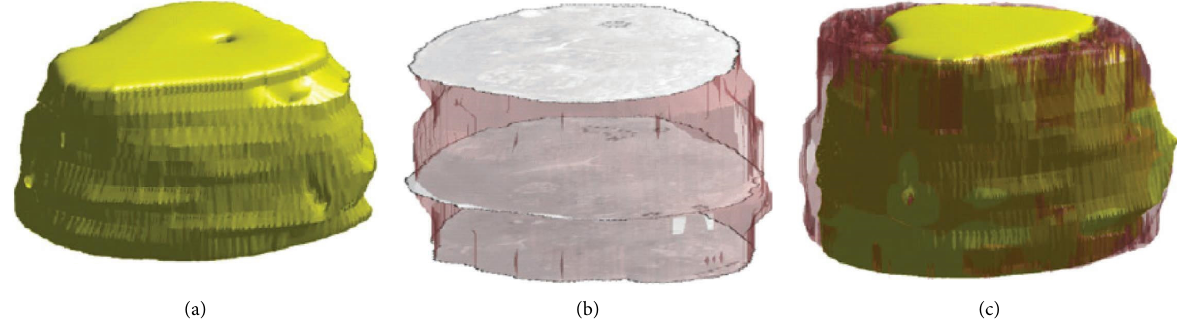
Figure 10: Expanding on their group-wise image-to-image registration, Xiao et al. [10] undertook eforts to reconstruct the original tissue in silico. Te rendered MRI volume (a) was registered with the reconstructed histology volume (b) of the human prostate. Te resulting joint volume is portrayed in (c). Reprinted from computerized medical imaging and graphics, 35/7–8, Gaoyu Xiao, B Nicolas Bloch,